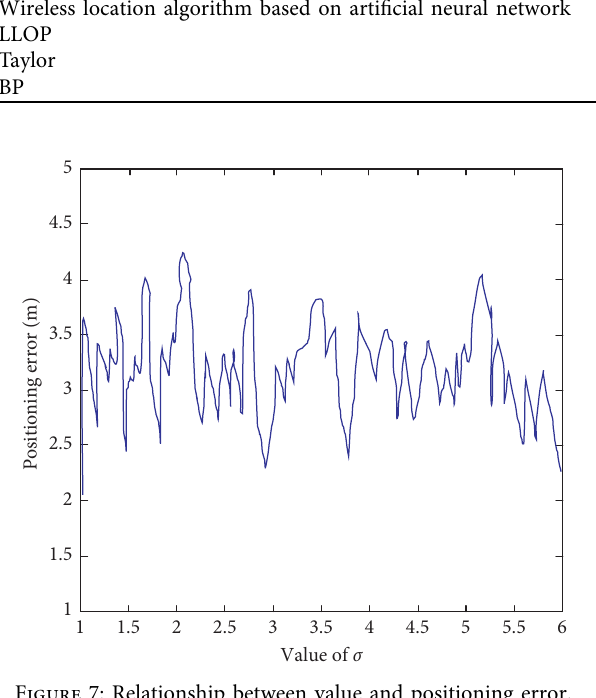
Figure 9: Comparison of real trajectory and one-time tracking